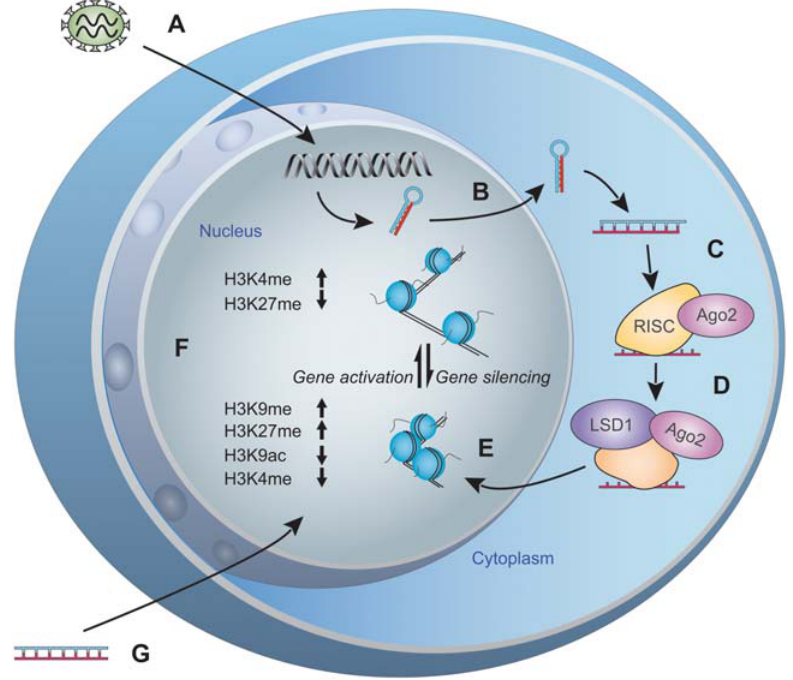
Figure 2 A model representing possible mechanisms of small RNA-mediated gene regulation. (A) Lentiviral vectors encoding the small hairpin RNAs (shRNAs) integrate into the target cell genome. (B) Pri-shRNAs are expressed and transported to the cytoplasm. (C) Pri-shRNAs are processed into shRNA duplexes by Dicer and bound to RNA-induced silencing complex (RISC). (D) The complex goes through processing in which the histone modifying transcription factors are attached to it. (E) The complex is transported back into the nucleus where it recognizes its target sequence in the genome. (F) The complex modulates target gene activity by regulating transcription via histone acetylation and methylation. (G) The target gene activity can also be altered with other small RNAs w e.g., small interfering RNA (siRNA) transfection x . The model is based on our studies of VEGF-A regulation by shRNAs described in reference